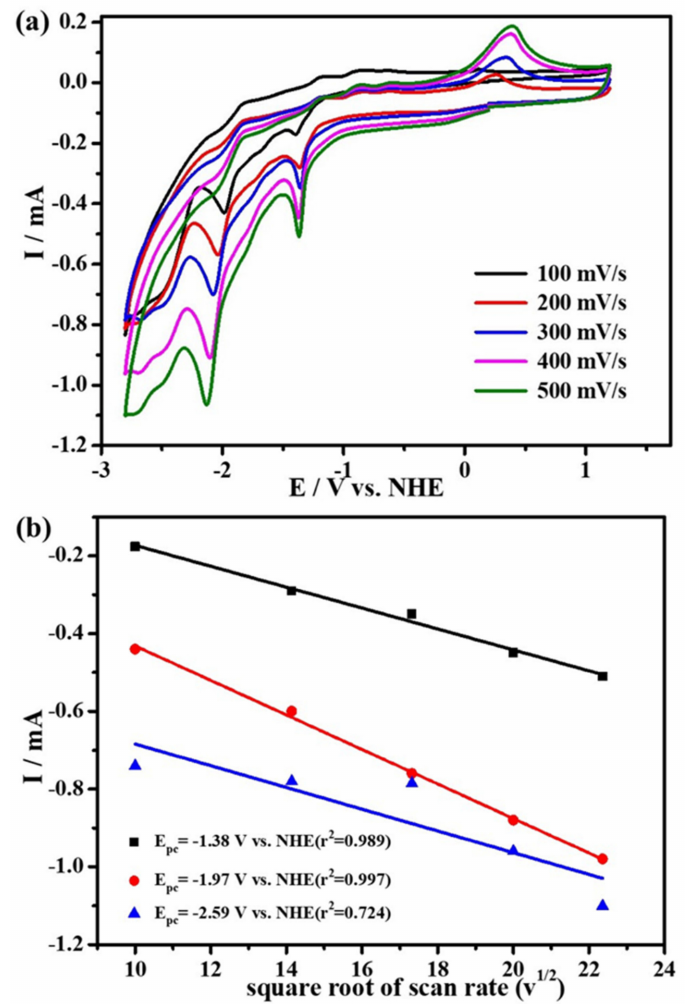
Figure 2. ( a ) cyclic voltammetry of 2 mM complex 1 under 1 atm Ar with 0.1 M n Bu 4 NPF 6 as supporting electrolyte at scan rates range from 100 to 500 mV s − 1 ; and ( b ) the linear relationships between the peak cathodic currents and the square root of scan rates.